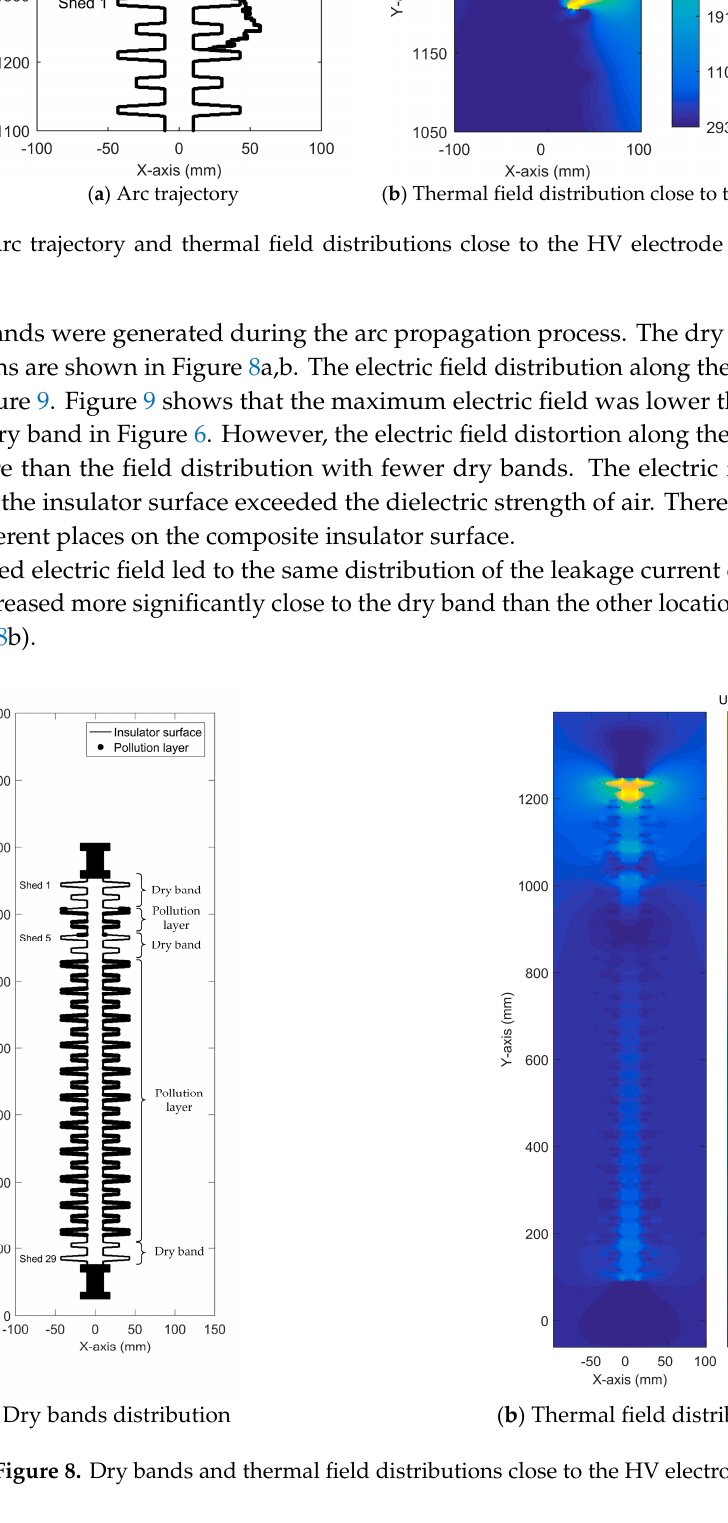
Figure 6. Electric field comparison with different lengths of the dry band.